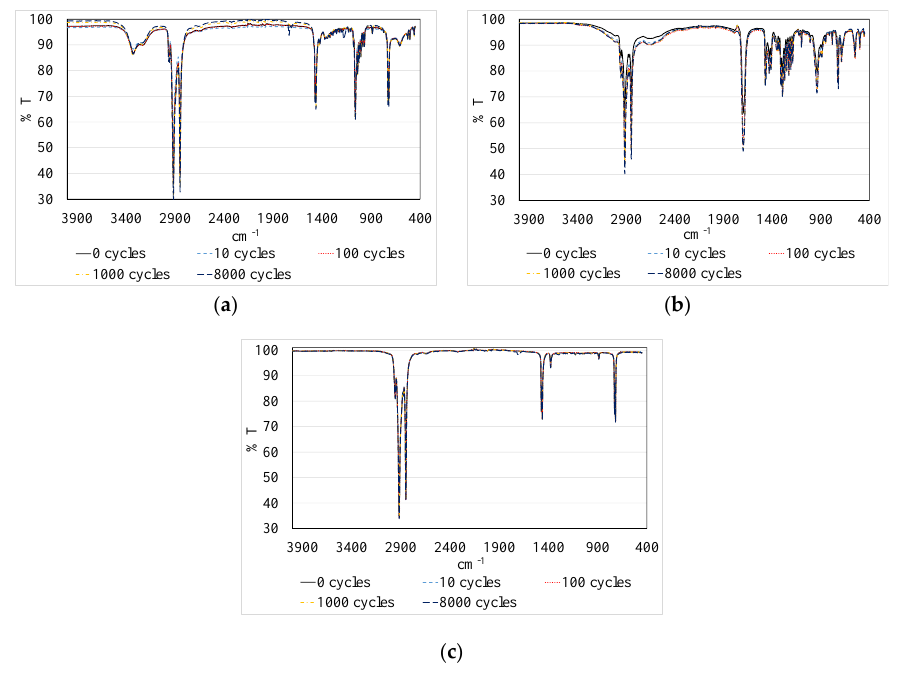
Figure 6. FT–IR analysis of the cycled PCM. (a) RT64HC; (b) PureTemp 63; (c) THP5860.